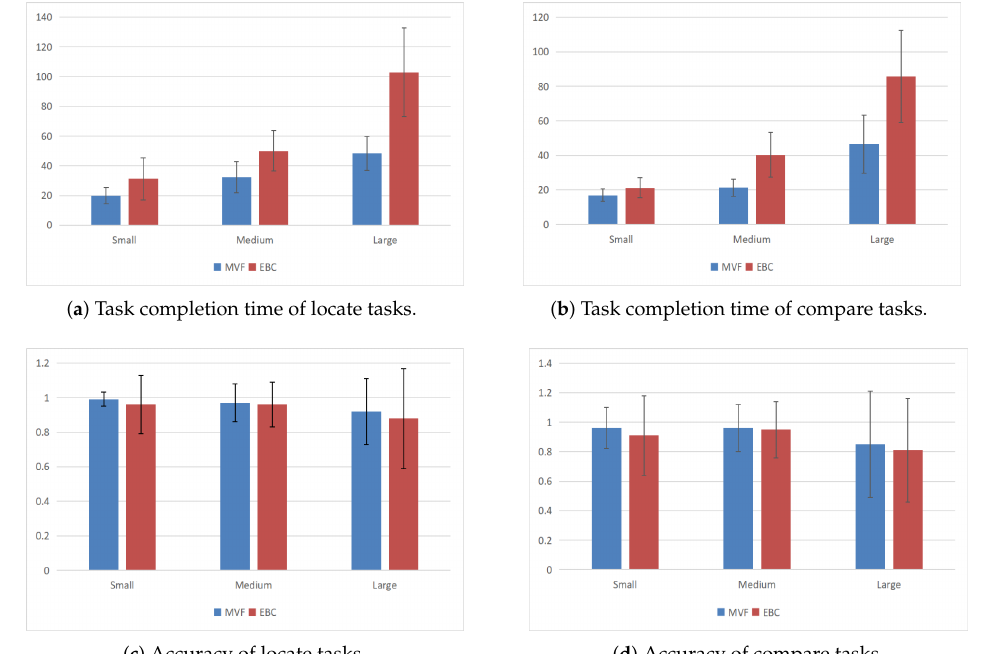
Figure 7. Results regarding task completion time in seconds. Error bars indicate the standard deviation of the measured mean.